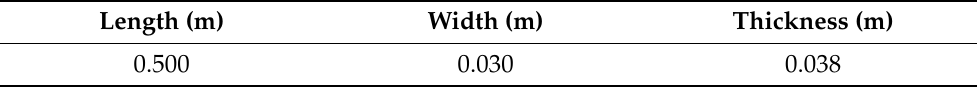
Table 9. Dimensions of the test specimen for verification of bending strength.